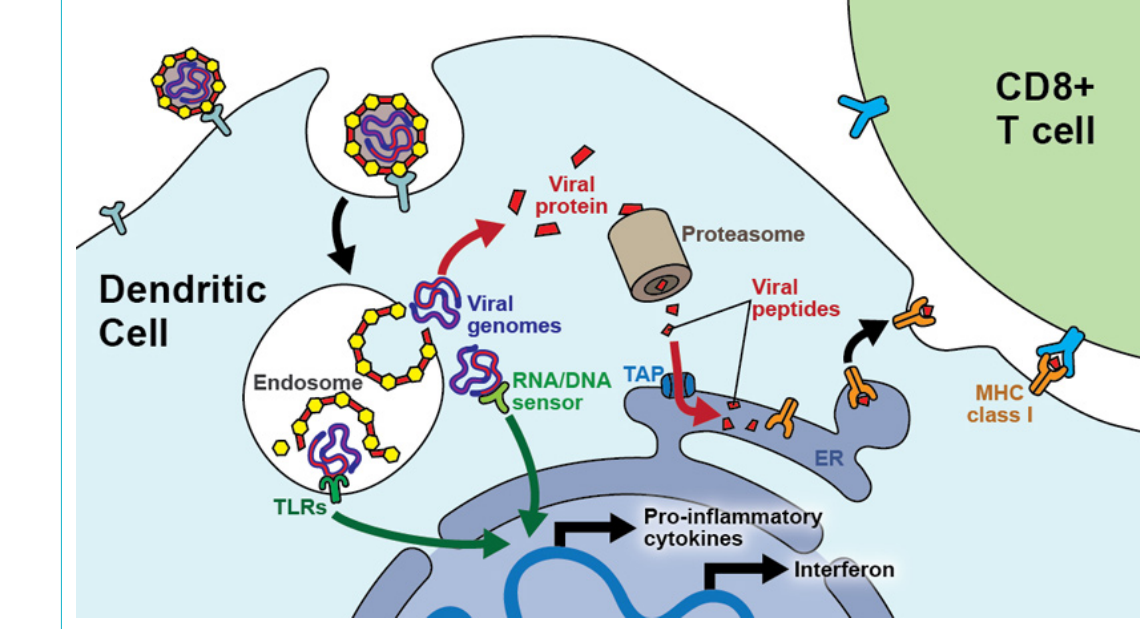
Figure 2: Mechanisms of immune activation by virally vectored vaccines.Vaccine vector particles infect dendritic cells (DCs) of a vaccinee. In this schematic, the vector particles are taken up by receptor-mediated endocytosis and inside the endosome release their genome into the cy- toplasm of the DC. If the viral genome gets exposed inside endosome rather than being released into the cytoplasm, Toll-like receptors (TLRs) sense it. Once inside the cytoplasm, the viral genome is amplified and sensed by cytoplasmic sensors of viral nucleic acids (“RNA/DNA sen- sor”). Both pathways signal through common pathways such as the NFκB and MAPK pathways, resulting in the transcriptional activation of pro-inflammatory cytokines but also in type I interferon production. Altogether, these events lead to functional activation of the dendritic cell. Si- multaneously, the viral genomic information will be expressed, leading to synthesis of viral proteins. A proportion thereof is degraded by the proteasome and the resulting peptidic fragments are channelled through the transporter associated with antigen presentation (TAP) into the endoplasmic reticulum (ER). Inside the ER, these viral peptides are loaded onto MHC class I molecules, which are then exported to the cell surface for presentation to virus-specific CD8+ T cells. Simultaneous functional activation of the DC by the aforementioned innate sensors warrants efficient CD8+ T cell